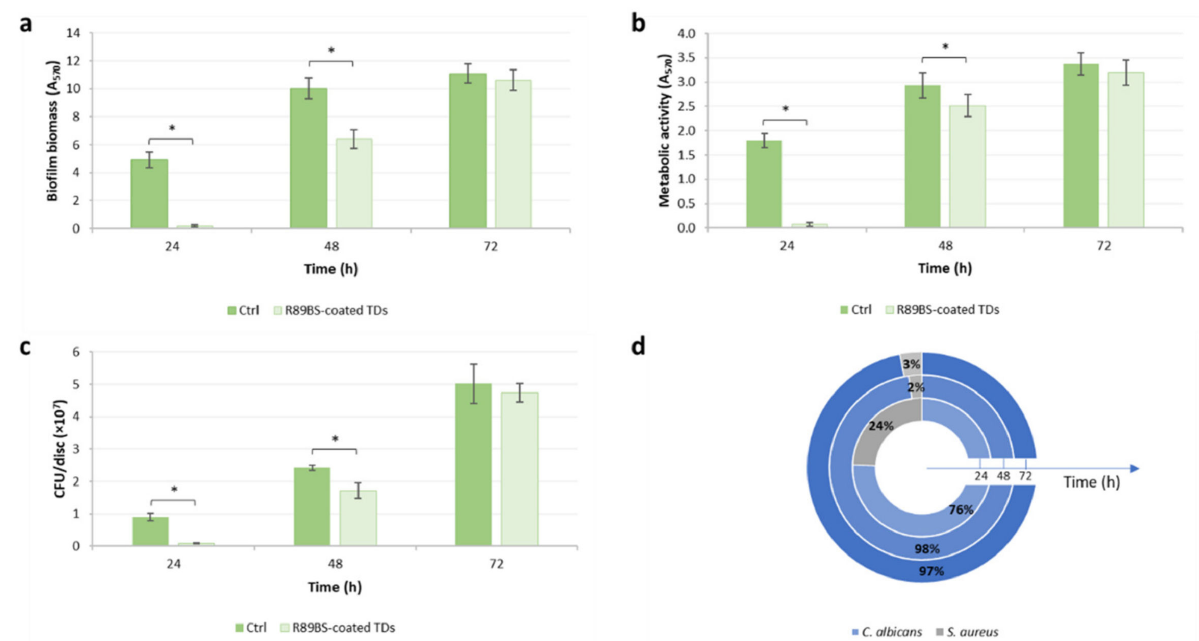
Figure 2. Biomass ( a ), metabolic activity ( b ) and cell viability ( c ) of C. albicans - S. aureus multi-species biofilm formed on untreated control TDs (dark bars) and TDs coated with 4 mg/mL R89BS (light bars). Results were obtained by means of CV staining, MTT reduction assay and viable cell counting respectively, after 24, 48 and 72 h of incubation. The composition of the multi-species biofilm formed on R89BS-coated TDs ( d ) was determined by viable cell counting on selective agar media (Mannitol Salt Agar, selective for Staphylococcus, and Sabouraud Chloramphenicol Agar, selective for fungal growth) at the same time-points (24 h: internal pie; 48 h: middle pie; 72 h: external pie). Error bars represent standard deviation. * p < 0.05.